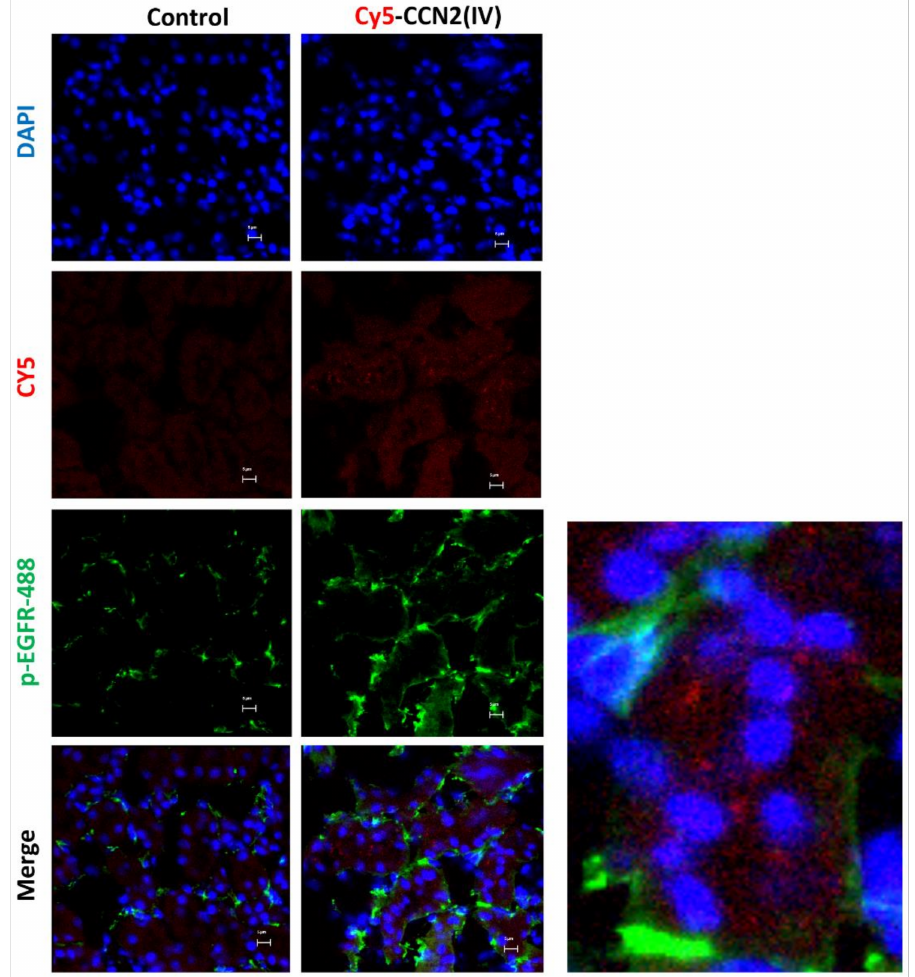
Figure 5. Localization of CCN2(IV) binding and EGFR activation in tubuloepithelial cells in vivo. C57BL/6 mice were injected with CCN2(IV)-Cy5 (2.5 ng/g of body weight, n = 3 mice per group) in the right kidney, using its corresponding contralateral kidney as control and sacrificed at 30 min. Figure shows Cy5-CCN2(IV) binding in red, activated EGFR in green (corresponding to phosphorylated EGFR (Alexa fluor ® 488)), and nuclei in blue (DAPI). The overlaid images show the colocalization of CCN2(IV) with EGFR activated in several tubule epithelial cells. A magnification is shown on the right. Figures show one representative mouse per group, and scale bar represents 5 µ